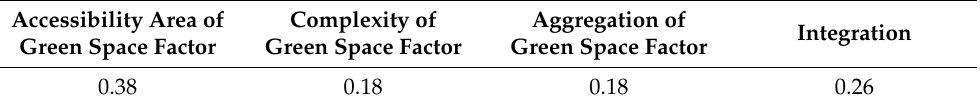
Table 7. Weight value of